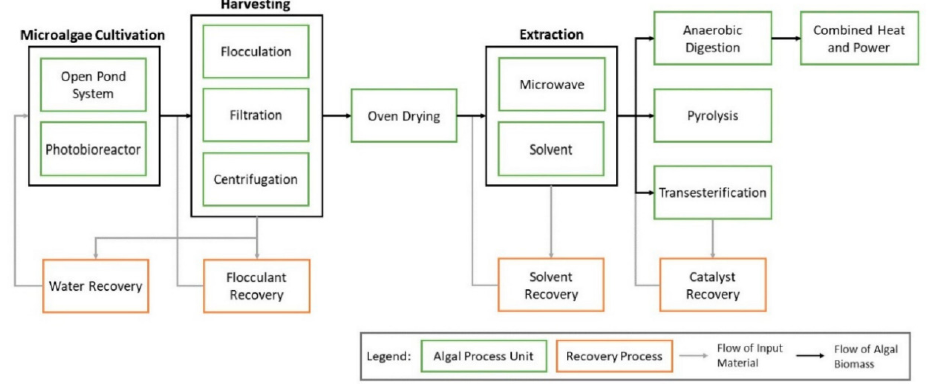
Figure 8. Algal biorefinery process flow [182].